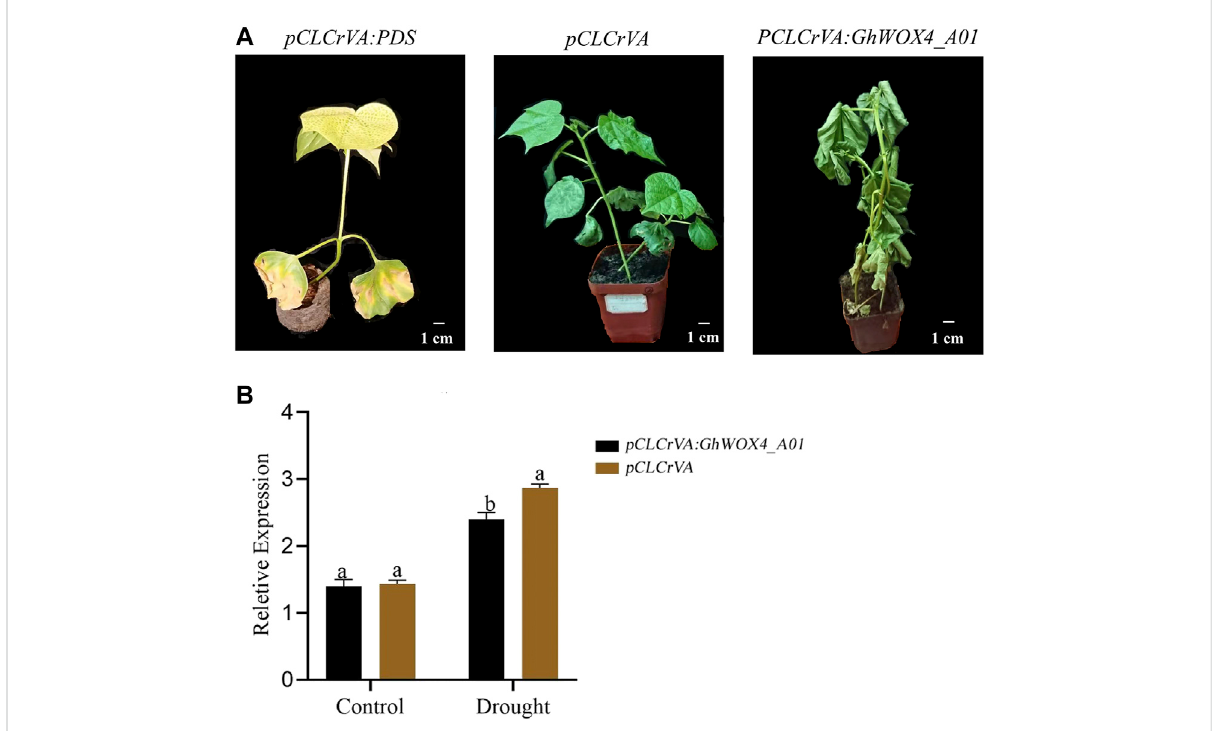
FIGURE 6 Phenotypic characterization of GhWOX4-A01 silenced plants. (A) Negative control, positive control, and GhWOX4_A01 silenced plants and (B) qRT-PCR analysis of GhWOX4_A01 in control and silenced plants under control conditions and after 10 days drought treatment. Different letters show signi fi cant differences at p <